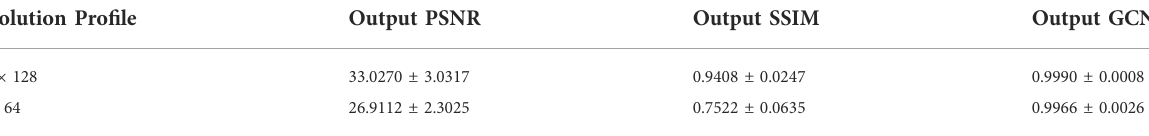
TABLE3 PSNR,SSIM,andGCNR result forthe ablationstudyonthe effectofdifferent resolutionpro fi leson themodelperformance.(128×128 Input PSNR = 32.1392 ± 2.7026, Input SSIM = 0.9279 ± 0.0252, Input GCNR = 0.9974 ± 0.0017) (64 × 64 Input PSNR = 26.0071 ± 2.3083, Input SSIM =